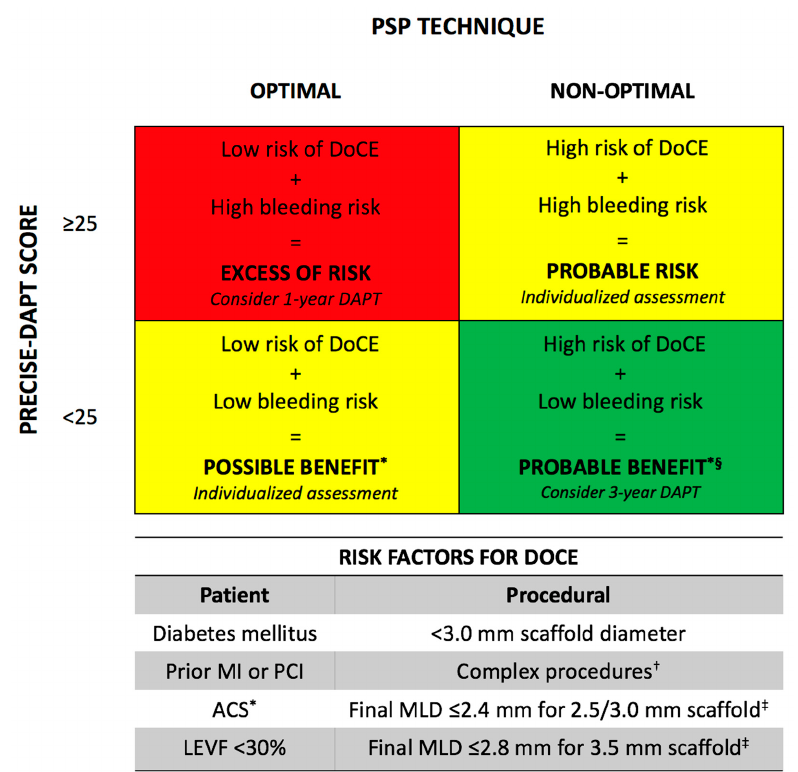
Figure 3. Risk factors to be considered for deciding to whom prolong dual-antiplatelet therapy following bioresorbable scaffold implantation. * Prasugrel and ticagrelor should be preferred over clopidogrel in ACS. † Complex procedures include ACC/AHA B2/C type lesions, >1 BRS implanted, or any other unfavorable clinical, angiographic, and procedural characteristics. ‡ Assessed by quantitative coronary angiography after PCI.4 § More intense regiment of DAPT could be considered in stable coronary artery disease patients: prasugrel/ticagrelor plus aspirin for 1-month, then de- escalation to clopidogrel plus aspirin [14]. DAPT: dual antiplatelet therapy; DoCE: device-oriented composite endpoint; MI: myocardial infarction; PCI: percutaneous coronary intervention; ACS: acute coronary syndrome; LEVF: left ejection ventricular fraction; MLD: minimum lumen diameter.